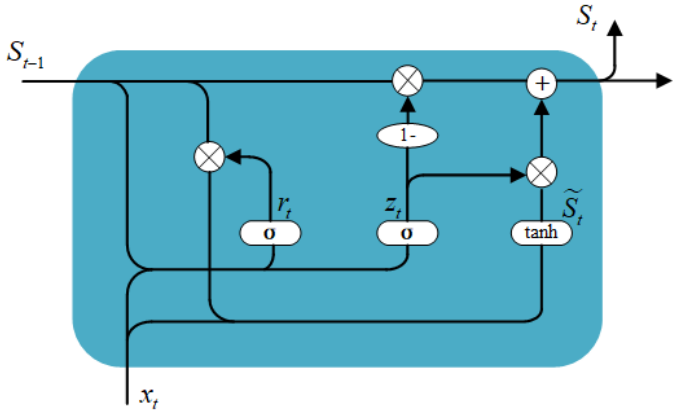
Figure 1. GRU network structure diagram.